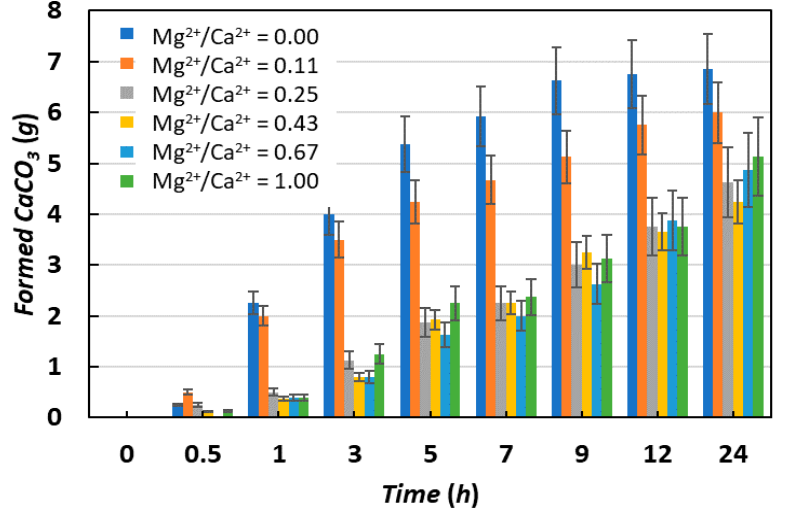
Figure 8. Amount of CaCO 3 precipitated with time.